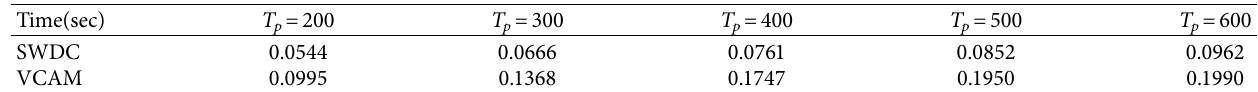
Figure 3: Example of detecting essential sensors. Table 2: Averaged CPU times.